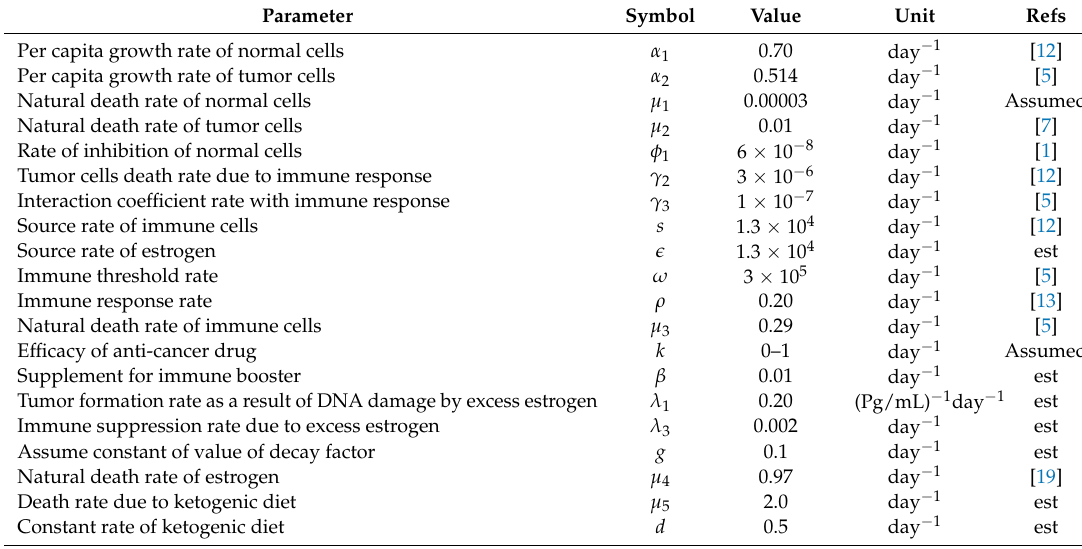
Figure 2. PRCCs of homogeneous model parameters with the tumor cells as the baseline variable. All parameter values were varied in 25 % of their baseline values in Table 1. The most sensitive parameters are shown to be valuesP  of 32 ,,  s and  are less than 0.01.